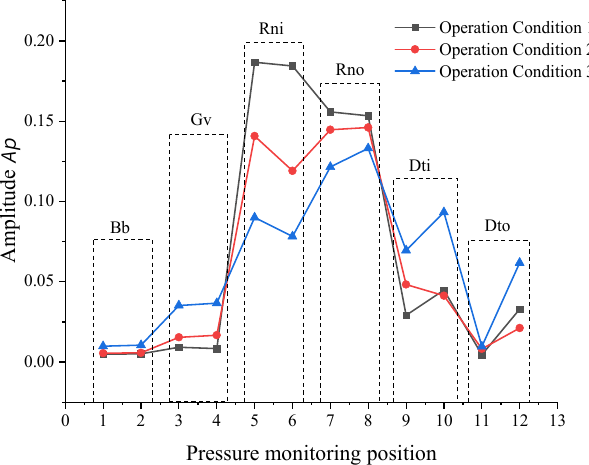
Figure 12. Pressure pulsation amplitude curves at different monitoring points under different conditions.